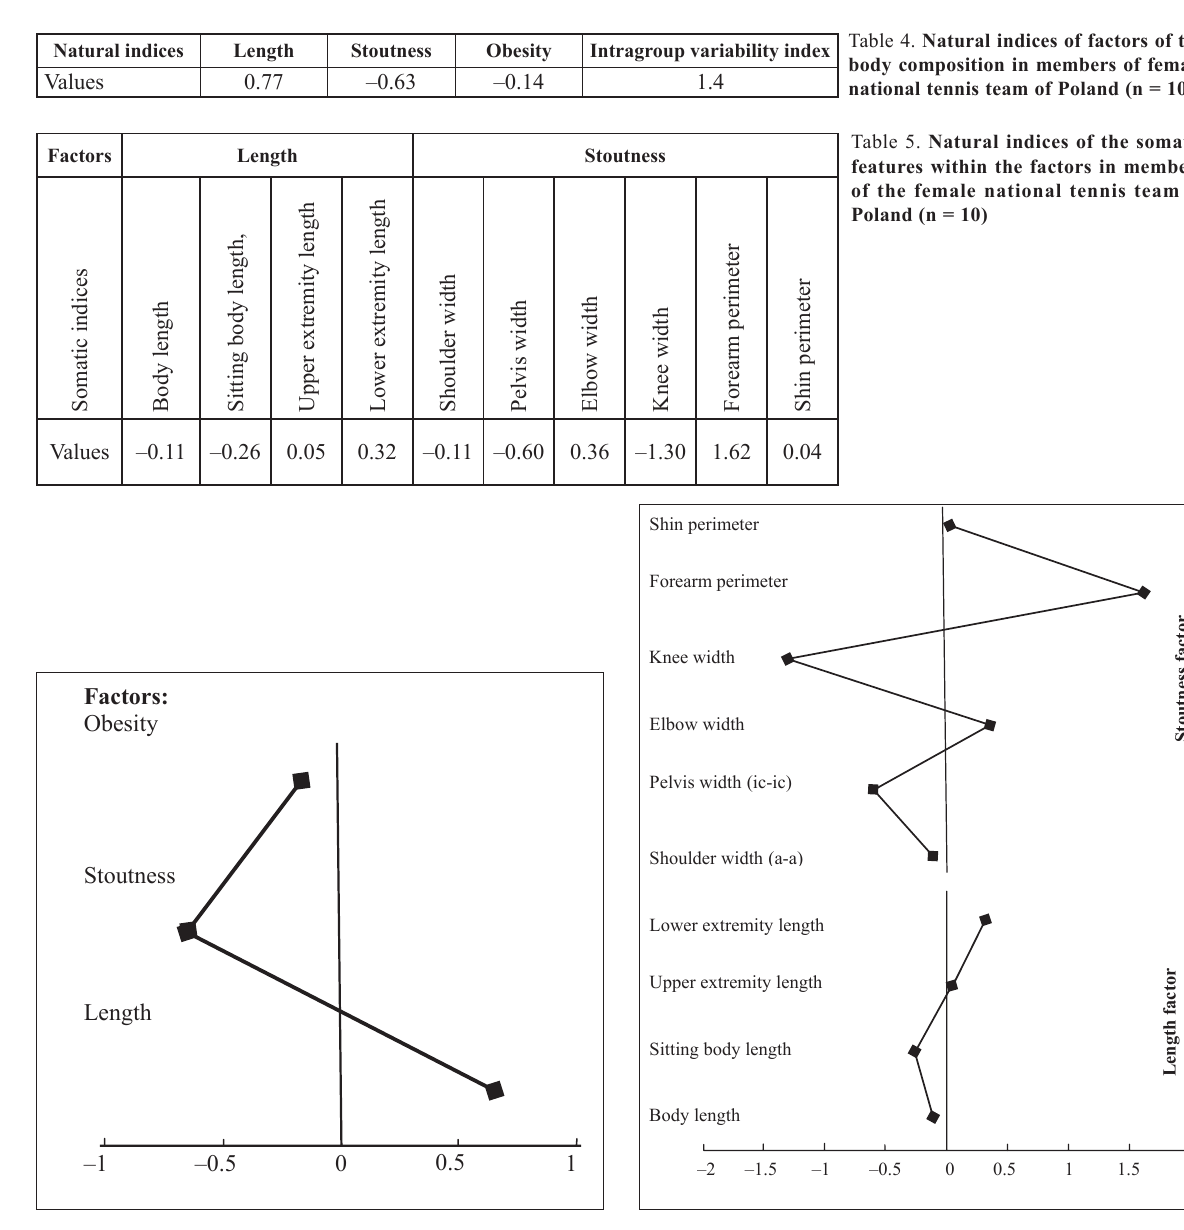
Fig. 1. Natural indices of factors of the body composition in members of the female national tennis team of Poland (n = 10)